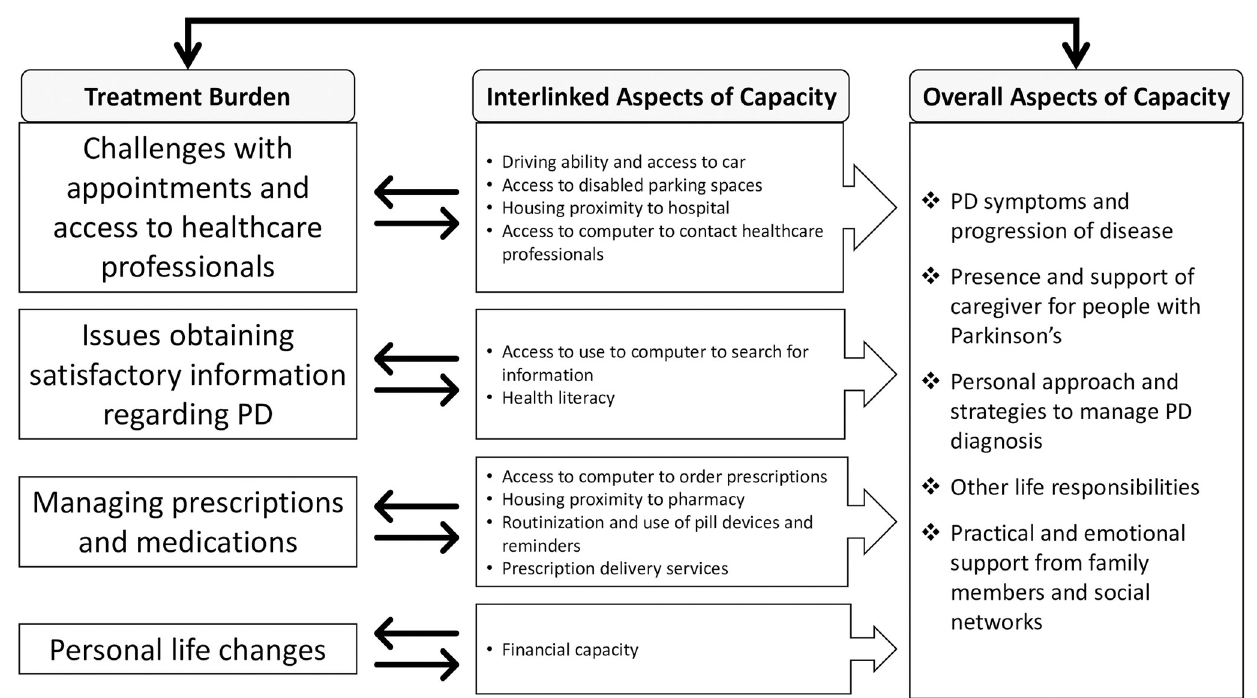
Fig 1. Interlinked and overall aspects of treatment burden and capacity in Parkinson’s